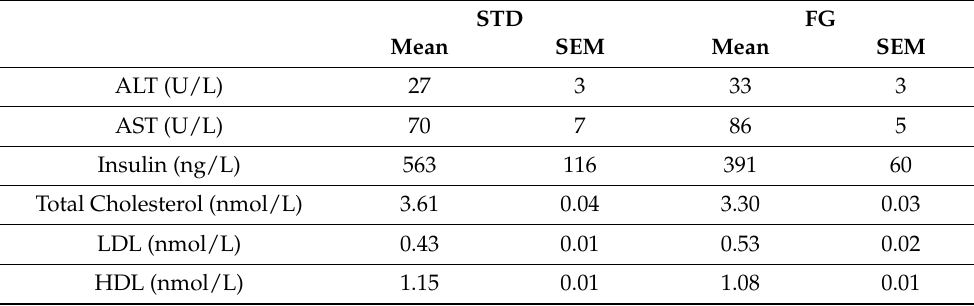
Table 1. Plasma variables in the STD and FG groups of rats ( n = 7–9/group) at the end of the study (week